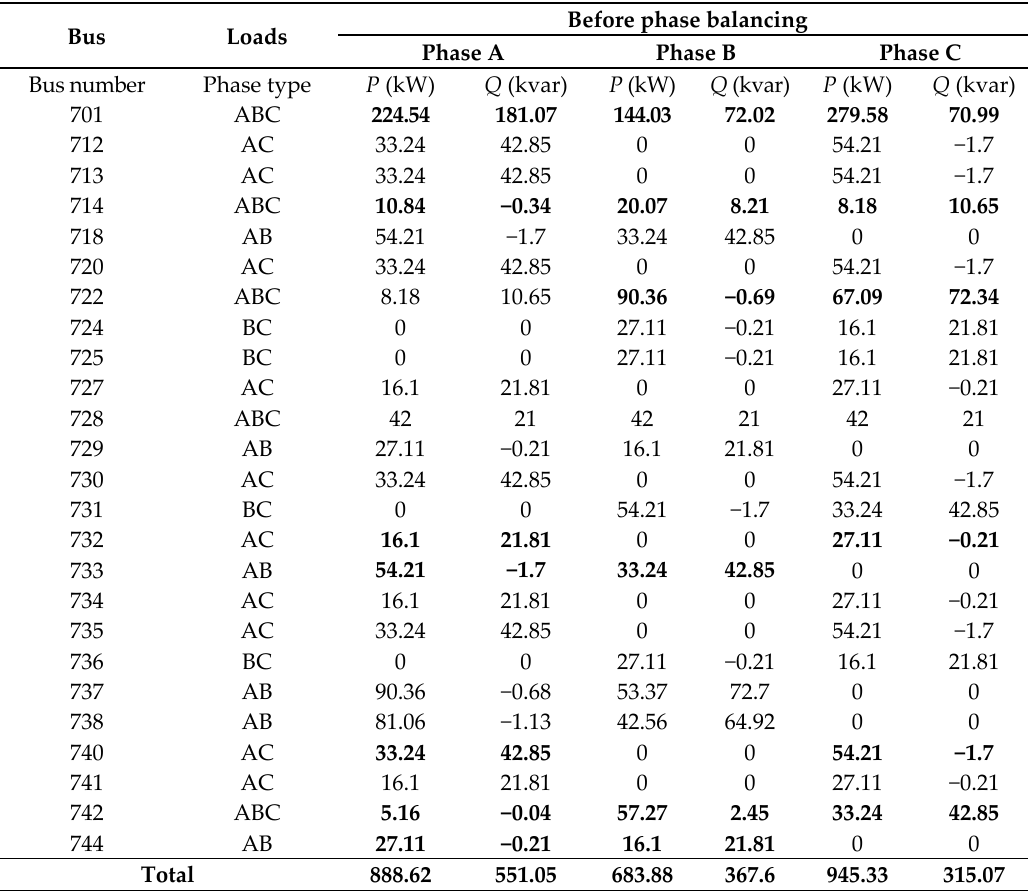
Table 2. Individual phase loads before and after phase balancing arrangement at each bus of IEEE 37- bus test